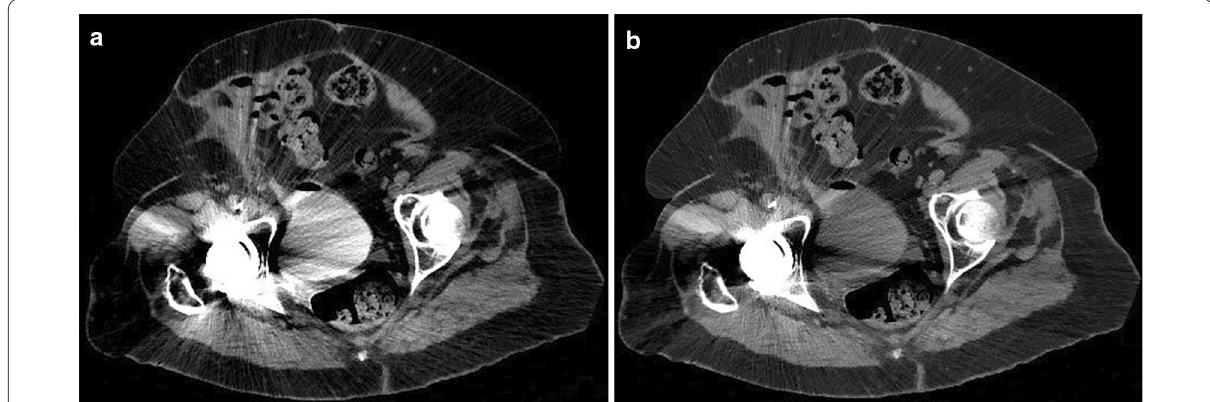
Fig. 3 CT cystography of a 70-year-old woman after renal transplantation with a prior total hip replacement. Beam hardening artifacts caused by metal hardware markedly degrade evaluation of pelvic structures ( a ). Spectral mono-energetic image at 140 keV shows improvement of artifacts, at a price of reduced attenuation of contrast in the bladder ( b